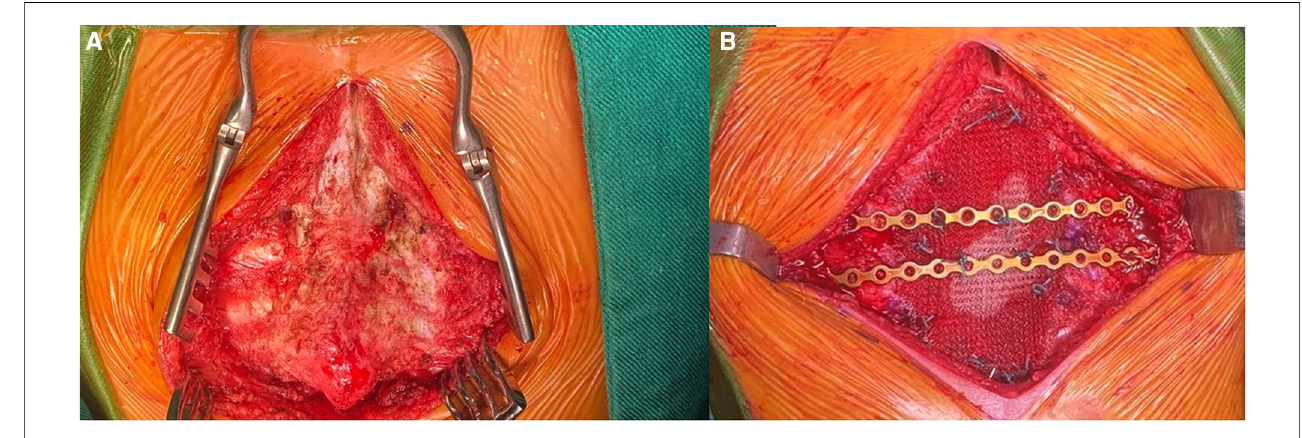
FIGURE 2 ( A ) Mass invading the costal cartilages and sternum. ( B ) Reconstruction with prosthetic